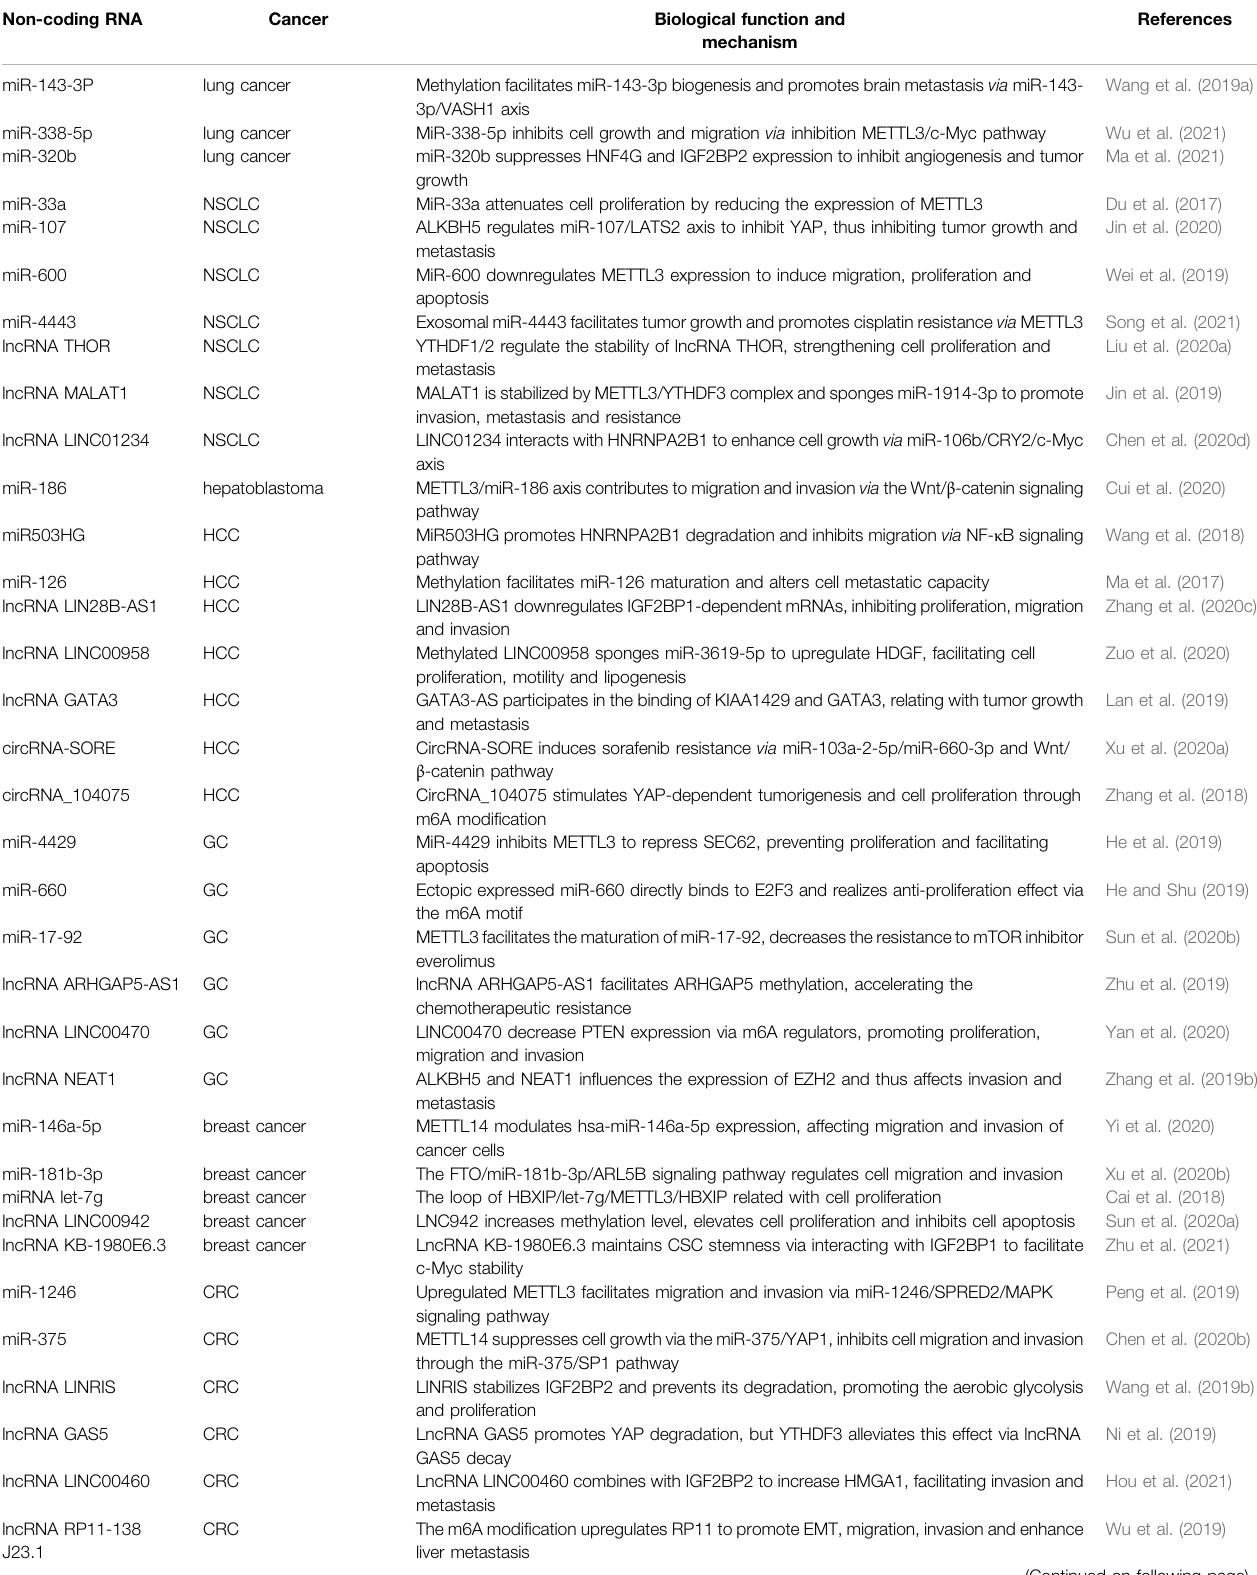
TABLE 1 | The biological function and mechanism of ncRNAs and m6A modi fi cation involved in cancer progression. Non-coding